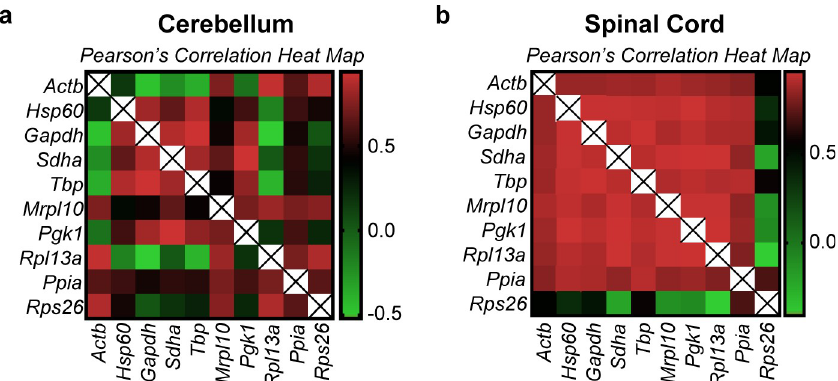
Fig 4. Pearson’s correlation heatmap of the linearized Cq values (2 -Cq ) of all genes. Pearson’s correlation of all genes was performed to identify the extent of expression correlation in (a) cerebellum and (b) spinal cord. The colour scheme is denoted next to each heatmap. The numerical values used in the colour scheme represent the Pearson’s r score. r = 0 (no correlation), r = +0.5 (positive correlation), r = -0.5 (negative correlation). r values closer to +1 or -1 denote strong positive and negative correlations respectively. The diagonal lines marked with an “X” are indicative of the correlation of a gene with itself and therefore is omitted from analysis.